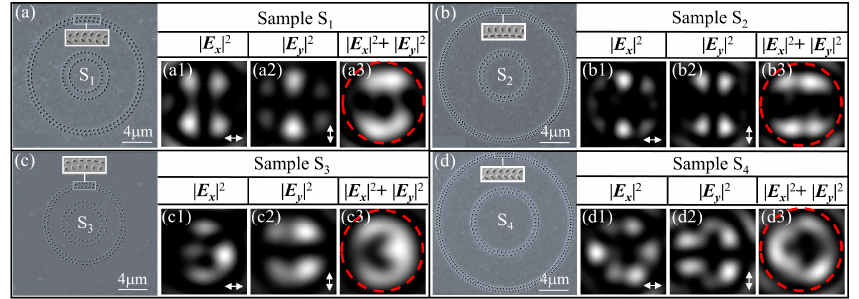
Figure 6. SEM images of the four samples and the experimental intensity images of the superimposed VBs. The insets show the magnified local images of the orthogonal slit-pairs.